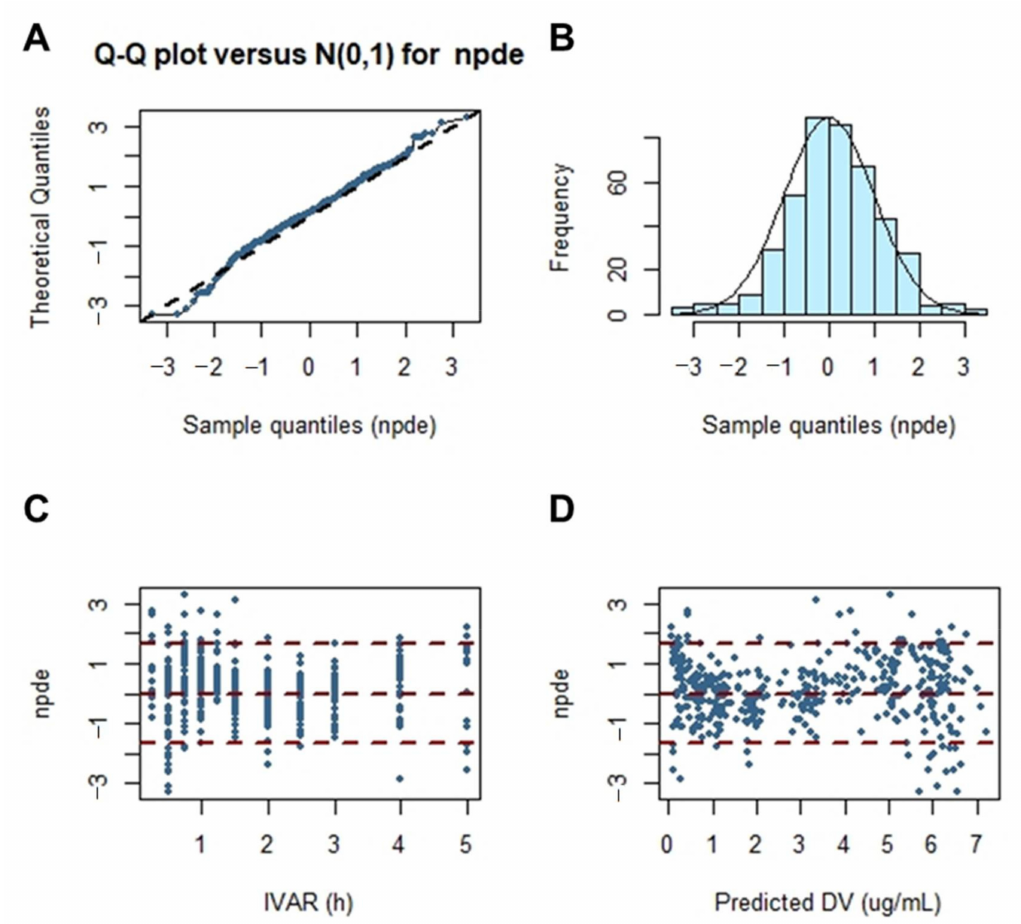
Figure 6. Normalized prediction distribution error for the final model. Quantile–quantile plots of normalized prediction distribution error versus theoretical n (0, 1) distribution ( A ). Histogram showing the distribution of normalized prediction distribution error overlaid with density of the standard Gaussian distribution ( B ). Scatter plot of time versus normalized prediction distribution error ( C ). Scatterplot of predictions versus normalized prediction distribution error ( D